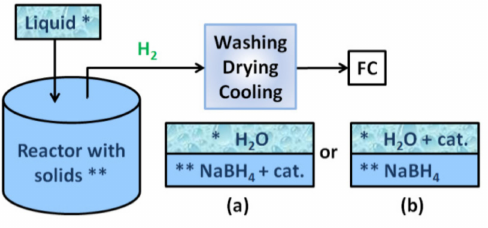
Figure 4. A schematic diagram of the hydrogen generation system with a batch reactor. Two ap- proaches are possible: ( a ) injection of water into a reactor with solid-state mixture of NaBH 4 with a catalyst in the form of powder, pellets, or tablets; ( b ) injection of solution with catalysts or catalyst precursor into a reactor with solid NaBH 4 ; * indicates the composition of liquid phase; ** indicates the composition of solid